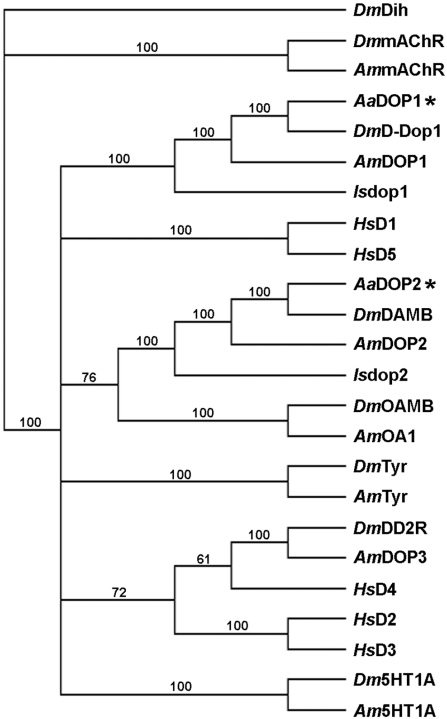
Neighbor-joining sequence analysis of Aedes aegypti AaDOP1 and AaDOP2 and representative biogenic amine receptors.The deduced amino acid sequences for the mosquito dopamine receptors AaDOP1 and AaDOP2 and additional receptors for dopamine, muscarinic acetylcholine, octopamine, serotonin, and tyramine from Drosophila melanogaster and Apis mellifera, as well as the human D1-like and D2-like dopamine receptors were aligned for use in the analysis. Bootstrap values (100 replicates) are indicated with numbers at supported branches. The outgroup is a D. melanogaster diuretic hormone receptor, a Class B GPCR. Abbreviations: Aa = Ae. aegypti; Is = I. scapularis; Dm = D. melanogaster; Am = A. mellifera; Hs = H. sapiens. Sequences: Isdop1, D1-like dopamine receptor (ISCW001496); Isdop2, D1-like dopamine receptor (ISCW008775); DmD-Dop1, D1-like dopamine receptor (P41596); DmDAMB, D1-like dopamine receptor (DopR99B/DAMB: AAC47161), DmDD2R, D2-like dopamine receptor (DD2R-606: AAN15955); DmDih, diuretic hormone 44 receptor 1 (NP_610960.1); DmmAChR, muscarinic acetylcholine receptor (AAA28676); DmOAMB, octopamine receptor in mushroom bodies, isoform A (NP_732541); DM5HT1A, serotonin receptor 1A, isoform A (NP_476802); DmTyr, tyramine receptor (CG7431: NP_650652); AmDOP1, D1-like dopamine receptor (dopamine receptor, D1, NP_001011595); AmDOP2, D1-like dopamine receptor (dopamine receptor 2, NP_001011567), AmDOP3, D2-like dopamine receptor (AmDOP3, NP_001014983); AmmAChR, muscarinic acetylcholine receptor (XP_395760); AmOA1, octopamine receptor (oar, NP_001011565); Am5HT1A, serotonin receptor (5ht-1, NP_001164579); AmTyr, tyramine receptor (XP_394231); HsD1, D1-like dopamine receptor (D(1A), NP_000785); HsD2,D2-like dopamine receptor (D(2), NP_000786); HsD3, D2-like dopamine receptor (D(3), NP_000787); HsD4, D2-like dopamine receptor (D(4), NP_000788); HsD5, D1-like dopamine receptor (D(1B)/D5, NP_000789).